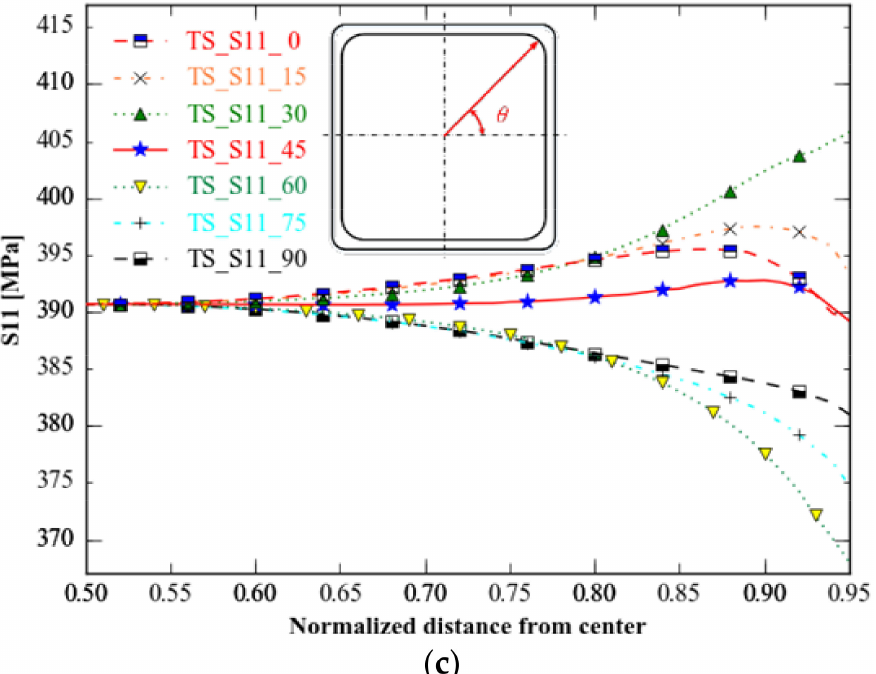
Figure 15. S 11 of the three specimens in nine directions. ( a ) Type A: unoptimised specimen; ( b ) type B: specimen with topology-only optimization; ( c ) type C: specimen with topology combined with shape